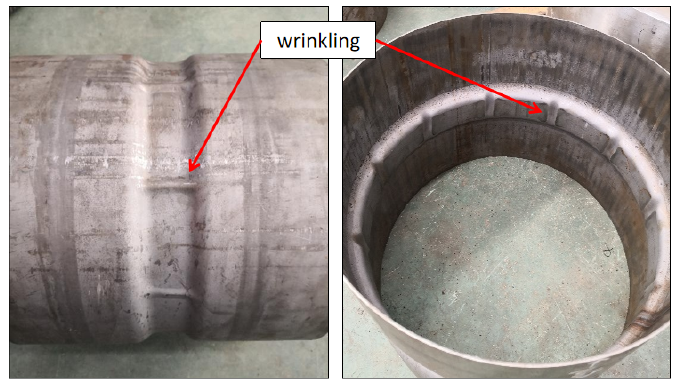
Figure 22. Wrinkling in experiments under the external pressure forming stage.